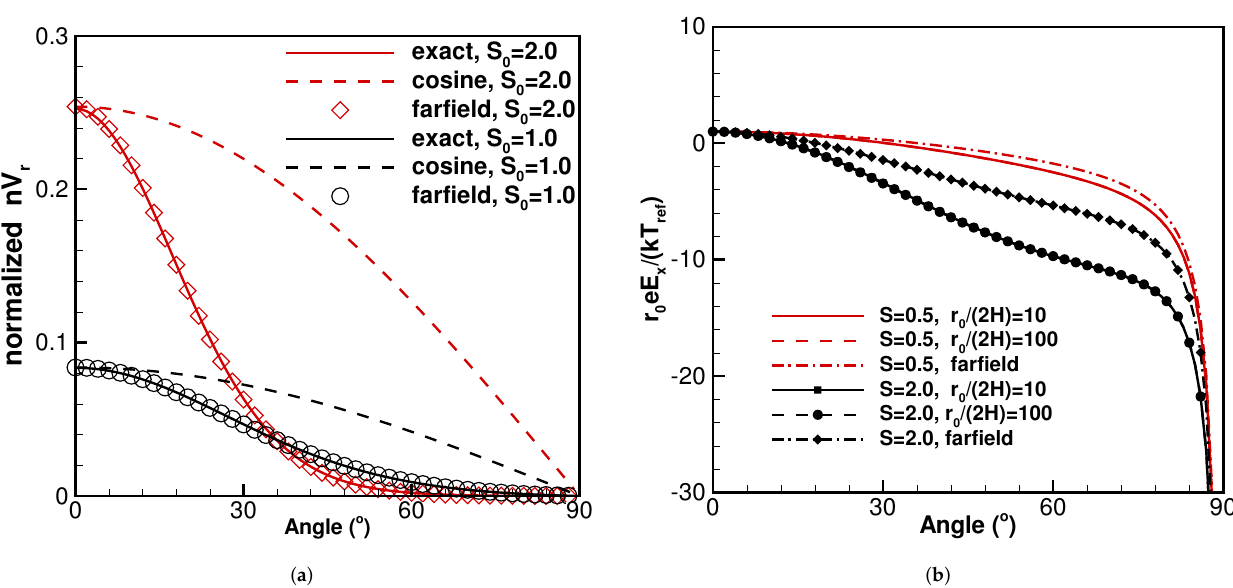
Figure 5. ( a ) Density flux profiles, r 0 / ( 2 H ) = 10; ( b ) Normalized electric field component, er 0 E x / ( kT 0 ) , at different angles. Figure 5b shows the normalized exact and farfield electric field component along the X-direction, at locations r 0 / ( 2 H ) = 10 and 100, and S 0 = 0.5 and 2.0, correspondingly. The curves are computed with Equations (12) and (22). For the exact solutions and specific S 0 value, the solutions for r 0 / ( 2 H ) = 10 and 100 coincident. There are appreciable difference between the exact and farfield approximations, and the deviations depend on the S 0 values. However, there is no doubt that they share the same